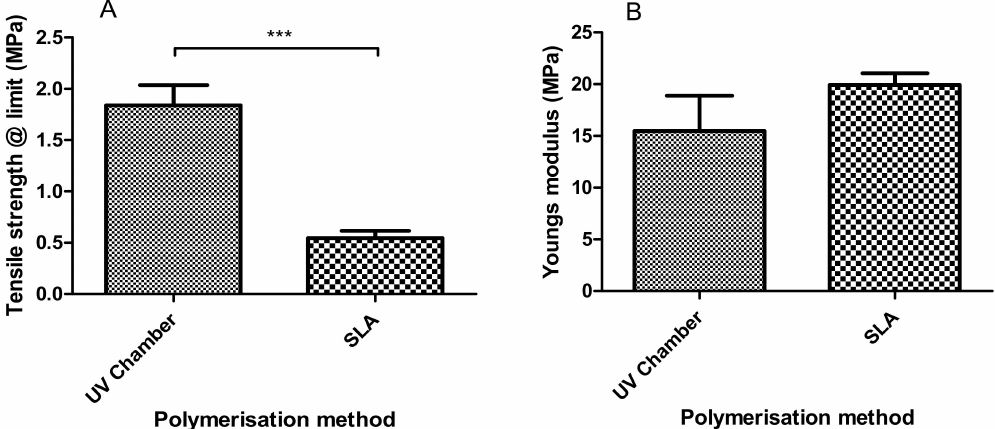
Figure 3. Dynamic mechanical analysis results showing ( A ) the tensile strength at limit and ( B ) Young’s modulus of the UV chamber-polymerised PEGDMA hydrogels and the SLA-polymerised PEGDMA hydrogels.